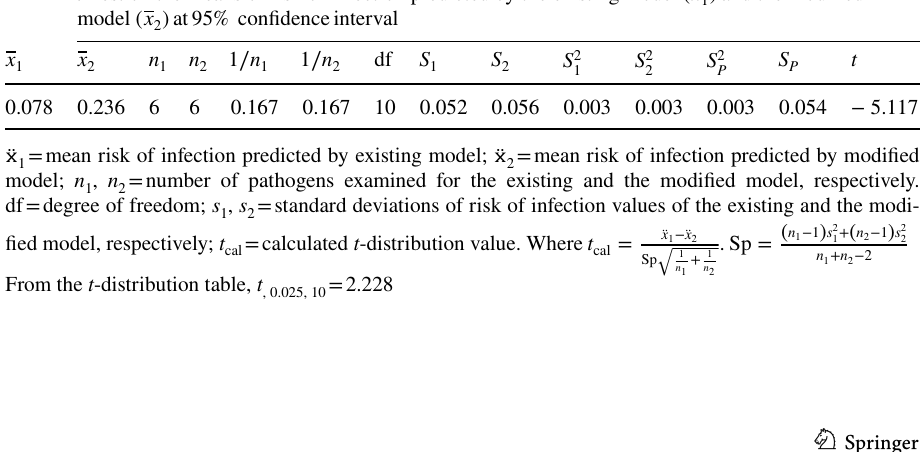
t -Test on the means of risk of infection predicted by the existing model ( x 1 ) and the modified x at95% confidenceinterval model ( 2 )